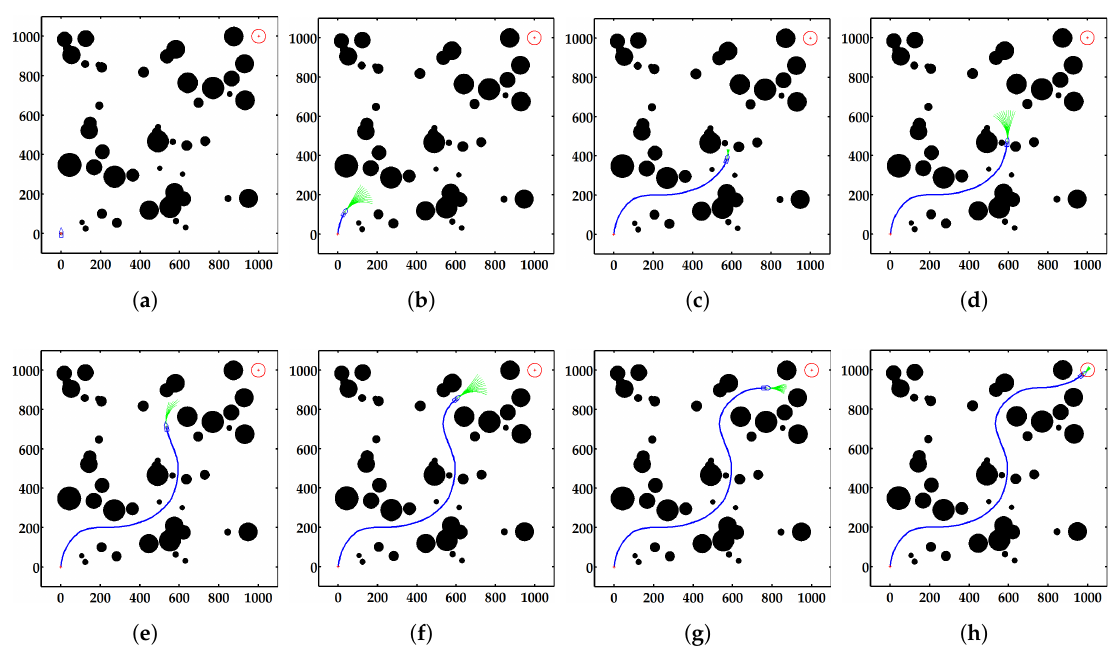
Figure 5. Demonstration diagram of the USV in a static environment. ( a ) Time 1 s; ( b ) Time 18 s; ( c ) Time 83 s; ( d ) Time 93 s; ( e ) Time 113 s; ( f ) Time 126 s; ( g ) Time 143 s; ( h ) Time 168 s.